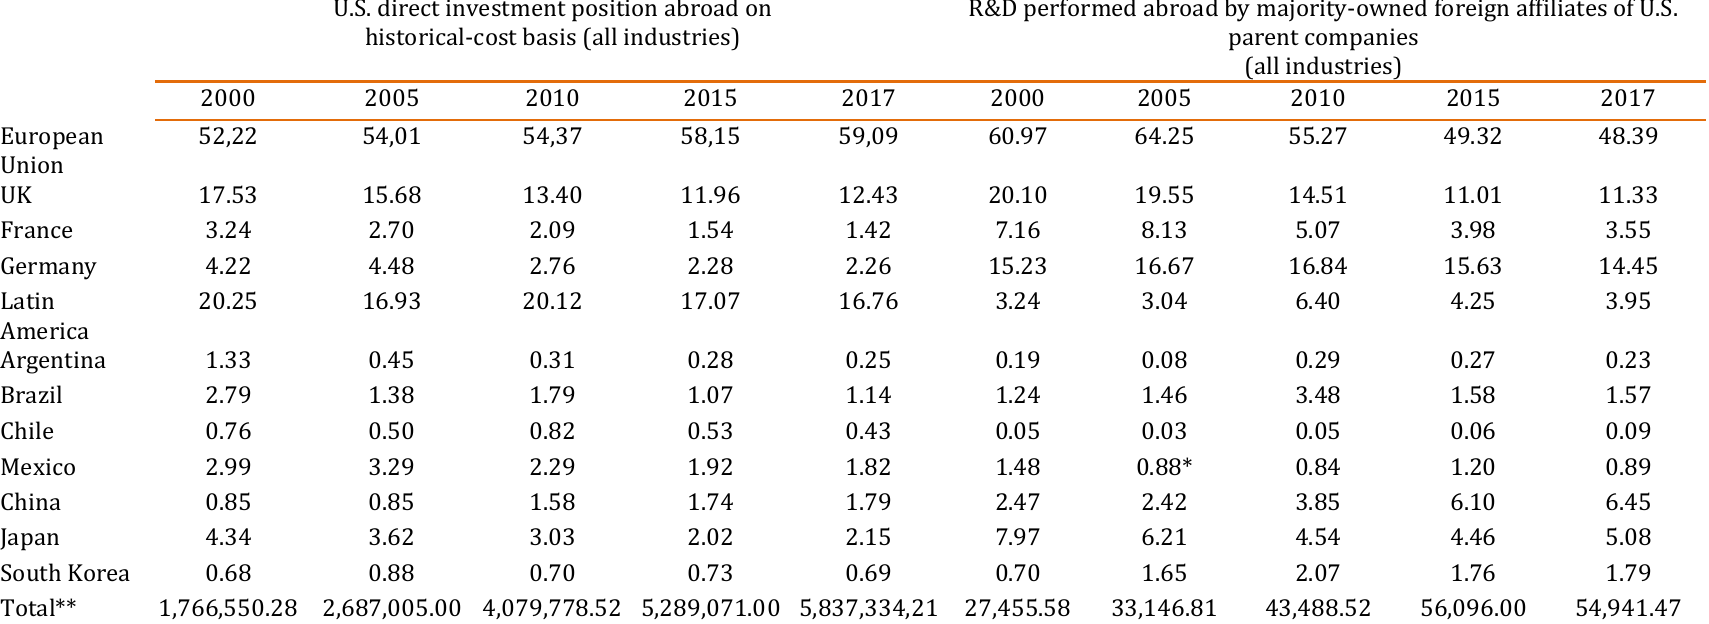
Table 02 . U.S. direct investment and U.S. R&D performed abroad, share in relation to total, selected countries, selected years U.S. direct investment position abroad on R&D performed abroad by majority-owned foreign affiliates of historical-cost basis (all industries)